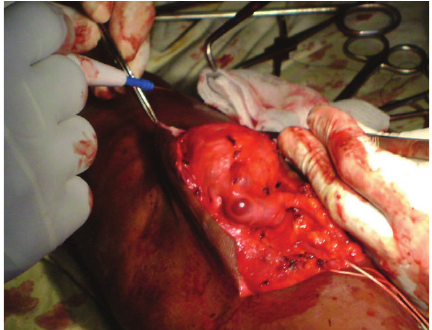
Figure 2: Dissection of the pseudoaneurysm. The elastic band is around the brachial artery. The vessels are massively distended. The fistula was between the venous comitans and the brachial artery. So the pseudoaneurysm was just under the skin but having a large communication with the brachial artery.